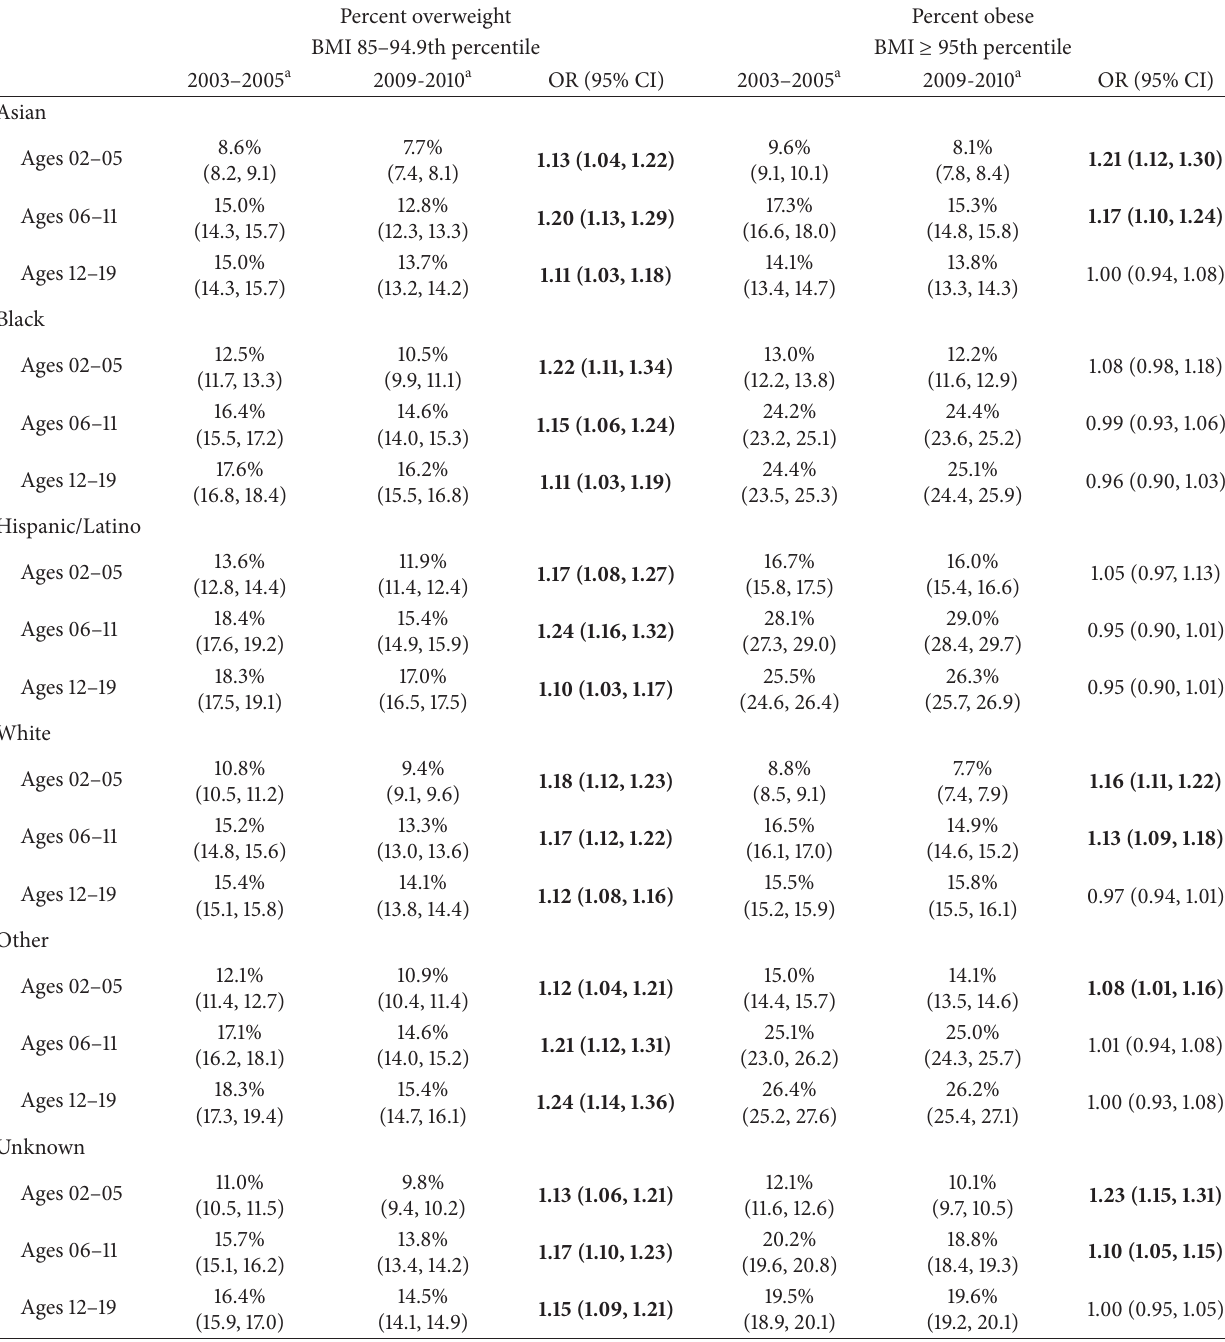
Table 3: Directly adjusted BMI category distribution by weight category, age, race/ethnicity, and time. Percent